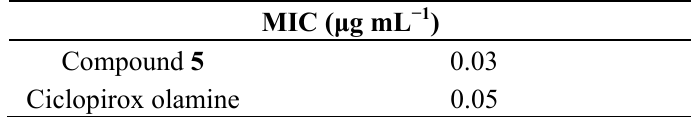
Table 2. MIC value obtained from compound 5 against Staphylococcus aureus (4006